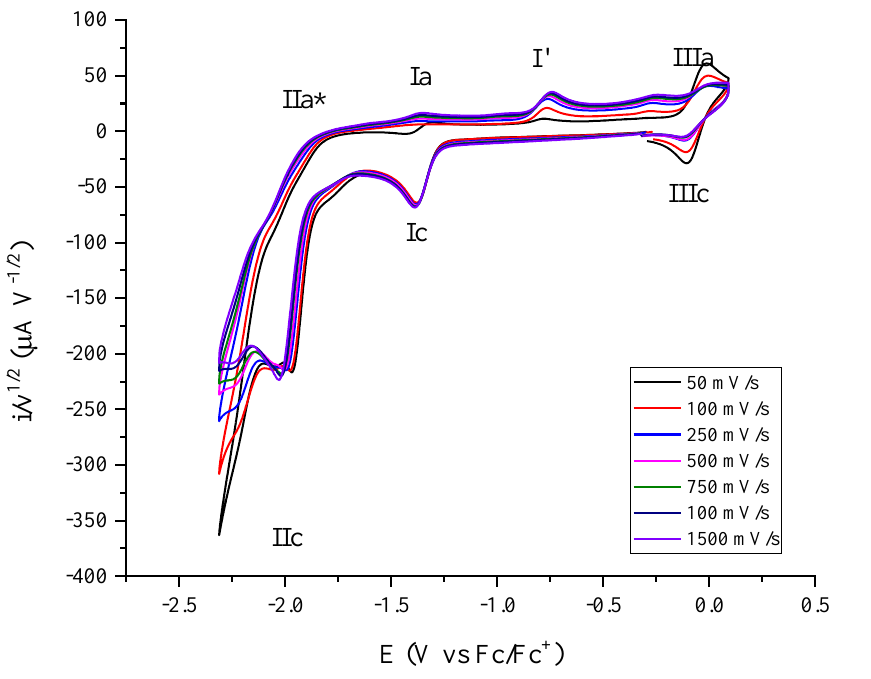
Figure 2. Normalized current cyclic voltammetry of 1 mM [Co II (bipy) 3 ](BF 4 ) 2 solution in MeCN with 0.1 M of TBAPF 6 as supporting electrolyte, bubbled with CO 2 from open-circuit potential to cathodic direction. Glassy carbon disk as a working electrode.